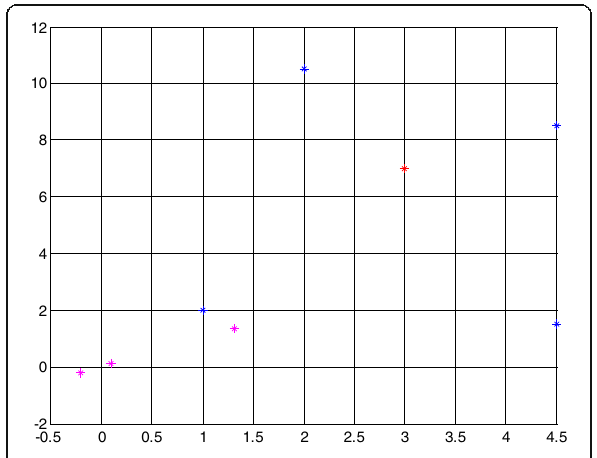
Fig. 8 Indoor measurement results (red star is the source location; pink stars are